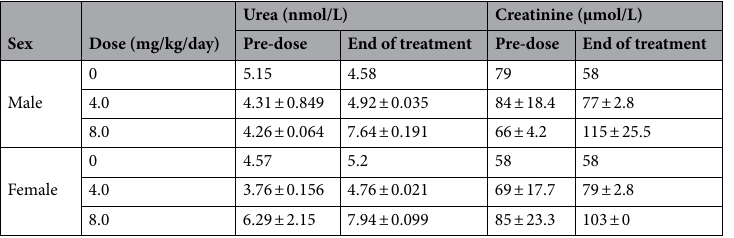
Table 5. Major differences of urea and creatinine in clinical biochemistry values (group mean values ± standard deviation) in beagle dogs treated with intravenous 30 min-short infusion of SET-M33 at 0 (vehicle = 0.9% saline solution), 4.0 and 8.0 mg/kg/day (7-day treatment period). Statistical analysis was not performed due to the small number of